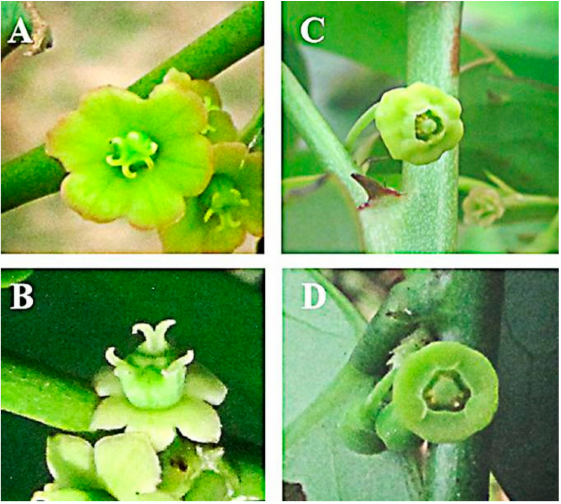
Figure 1. Flowers of the two Breynia species in this study: male flowers of B . fruticosa ( A ) and B . rostrata ( B ); female flowers of B . fruticosa ( C ) and B . rostrata ( D